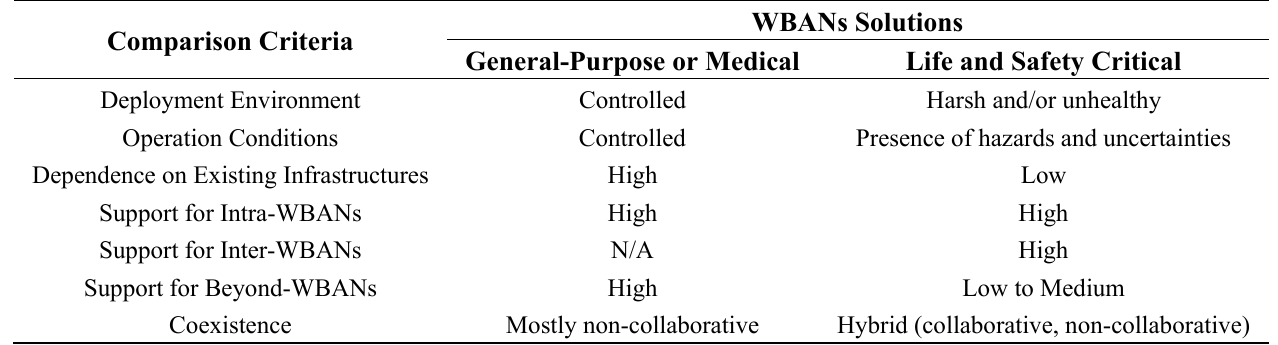
Table 14. WBAN Design